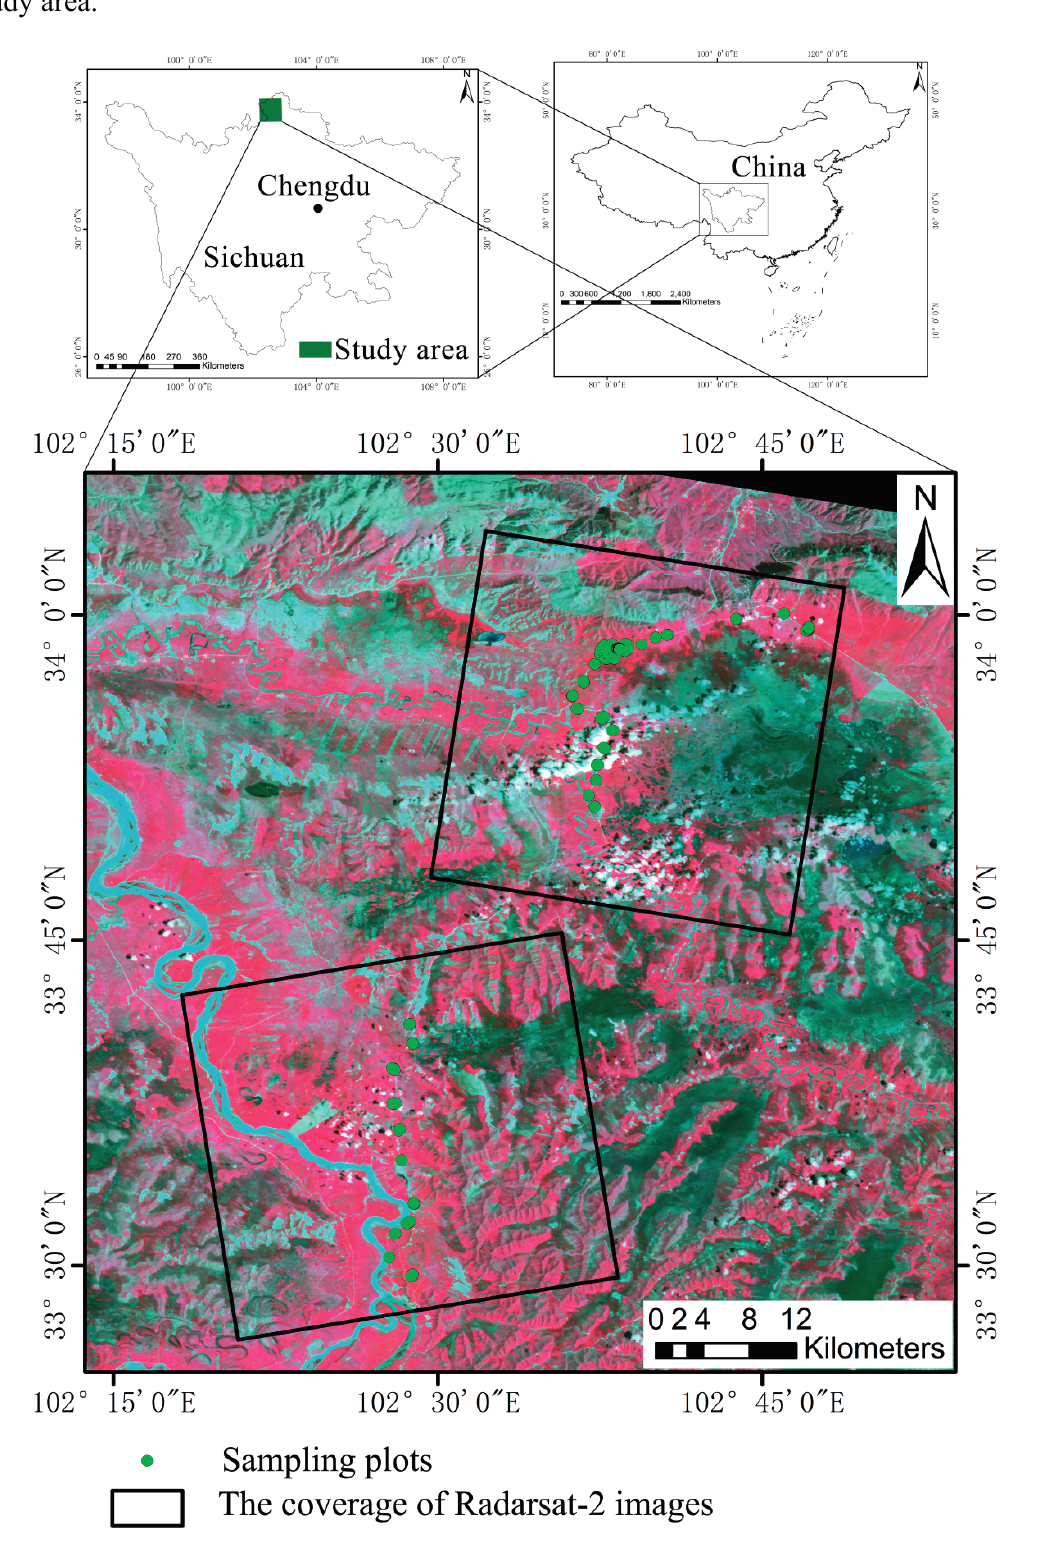
Figure 1. Location of study region and the distribution of sampling plots in the study area. The background image is a charge-coupled device (CCD) composite image of bands 4 (near-infrared), 3 (red), and 2 (green) (corresponding to R, G, B color space) showing the study